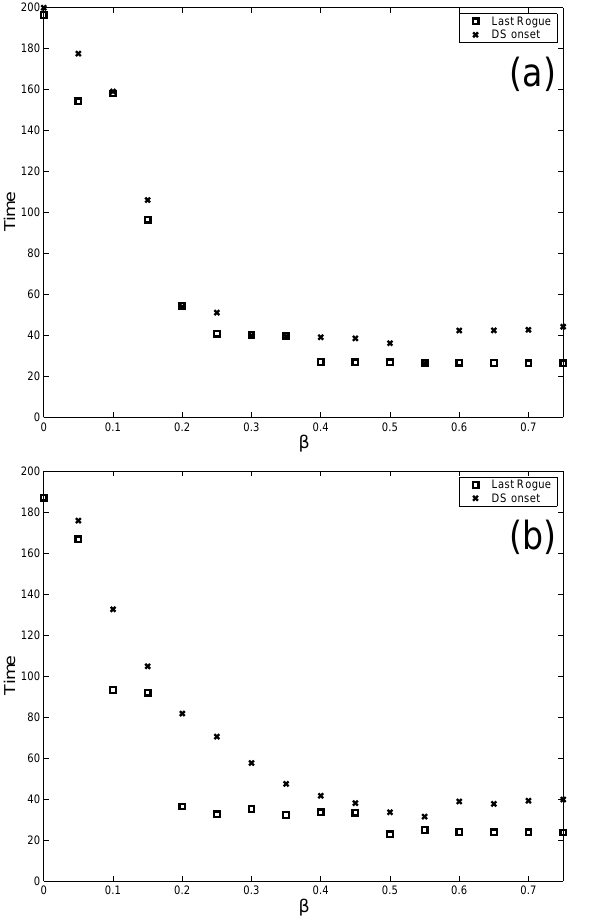
Fig. 14: The nonlinear damped HONLS eqn. with ǫ = 0 . 05 , Γ = 0 and 0 <β < 0 . 75. The time downshifting is irreversible (x) and the time the last rogue wave occurs (box) as a function of β , u 0 = a( 1 + 0 . 01cos µx) , where (a) a = 0 . 63 and (b) averaged over 0 . 57 <a < 0 . 67.